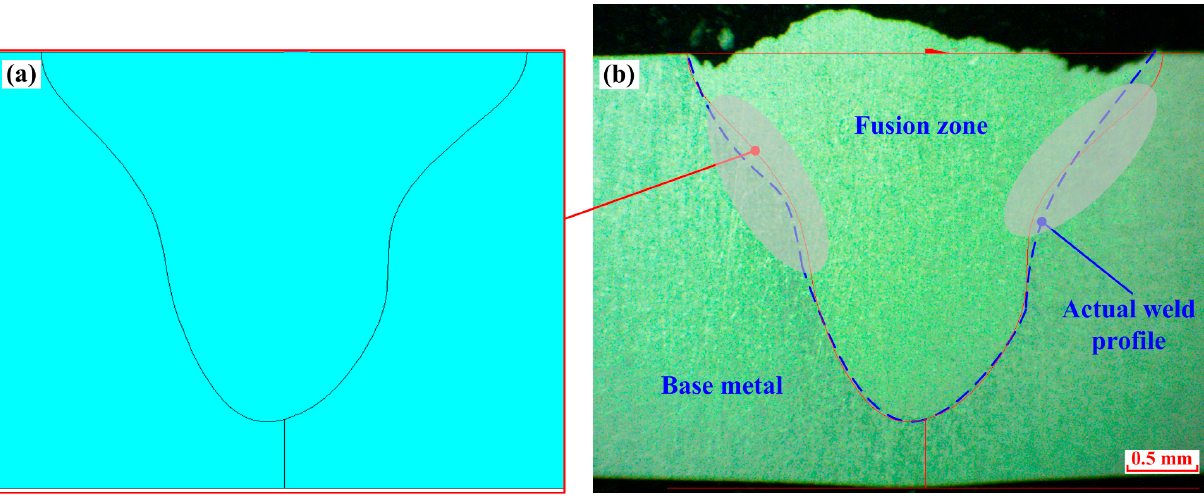
Figure 7. Fitting result of weld profile by B-spline curve: ( a ) reconstruction results of the weld profile, ( b ) Comparison results of experiment and fitting curves.